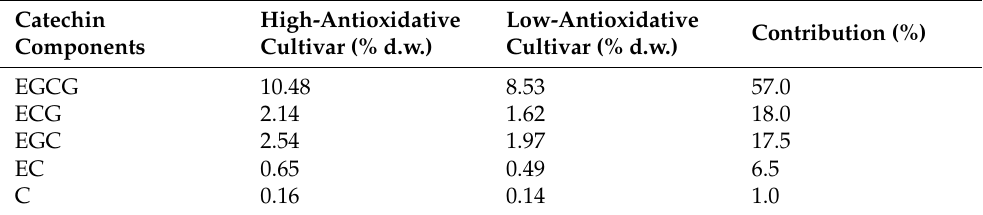
Figure 4. Performance of a subset of tea cultivars with high and low antioxidant capacities. ( a ) An- tioxidant capacities of selected tea cultivars. ( b ) Principal component analysis (PCA) depicting the differences between composite catechin profiles of tea cultivars exhibited high and low antioxidant capacities. Each bar represents the mean value ± SE (n = 5 cultivars for each group). Principal com- ponents (PC) 1 and 2 explained 66% and 21.1% of the variations, respectively. Each point represents the value for a single plot replication within each tea cultivar. The directions of black arrows indicate increasing catechin components. Statistical differences between high and low antioxidative tea cultivars were determined using MANOVA. Different case letters indicate significant differences in antioxidant capacity, represented as DPPH (lowercase) and ABTS (uppercase) scavenging capacities, between two groups of tea cultivars ( p < 0.05). Results of cultivars with high (cultivars 16 – 20 in Figure 1) and low antioxidant capacities (cultivars 1 – 5 in Figure 1) are highlighted in pink and blue, respectively. % d.w. = % foliar dry weight. Table 3. Mass fraction of individual catechin components in leaves of high- and low-antioxidative tea cultivars. Concentration means are shown in the order of contribution (%) of the catechin components to the overall dissimilarity between the high- and low-antioxidative tea cultivars as determined by SIMPER analyses. % d.w. = % foliar dry